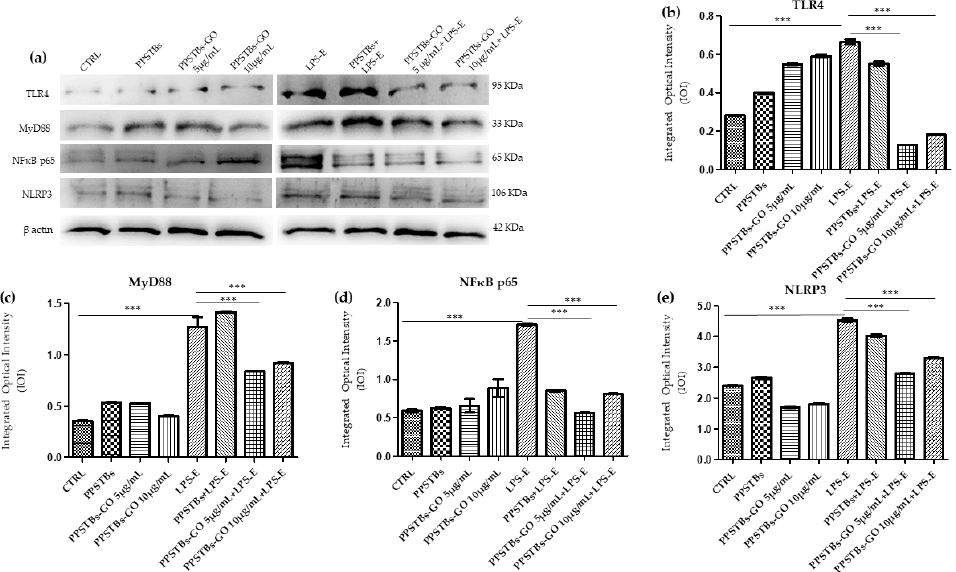
Figure 9. Western blotting analysis. TLR4, MyD88, NF κ B p65 and NLRP3 protein expression in the untreated hGFs cells (CTRL), in hGFs cultured with PPSTBs, in hGFs cultured with PPSTBs enriched with GO at 5 µ g/mL, in hGFs cultured with PPSTBs enriched with GO at 10 µ g/mL, in hGFs stimulated with LPS-E, in hGFs cultured with PPSTBs and stimulated with LPS-E, in hGFs cultured with PPSTBs enriched with GO at 5 µ g/mL and stimulated with LPS-E and in hGFs cultured with PPSTBs enriched with GO at 10 µ g/mL and stimulated with LPS-E. ( a ) Each membrane was probed with β -actin antibody to verify the loading consistency. ( b – e ) Histograms represent densitometric measurements of protein bands expressed as the integrated optical intensity (IOI) mean of three separate experiments. The error bars show the standard deviation (±SD). *** p < 0.001.